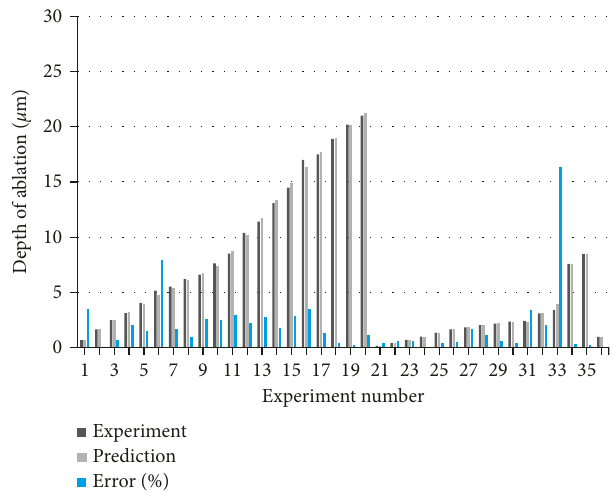
Figure 8: Graph comparing experiment and predicted depth of ablation including error prediction.